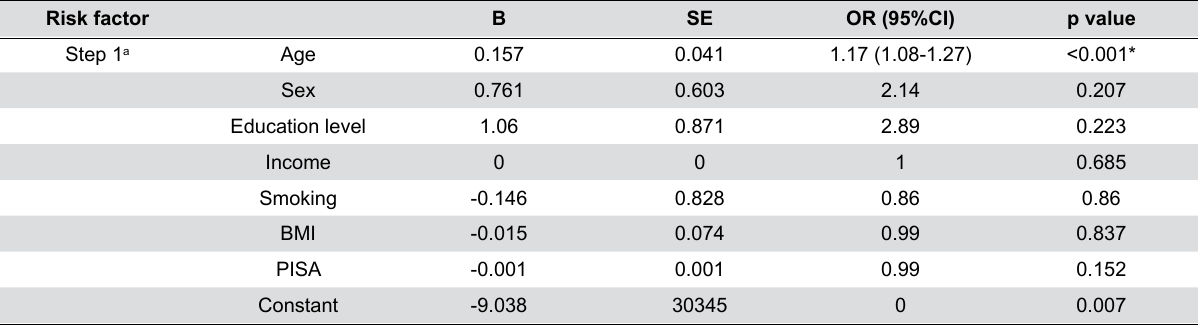
Table 5- Odds ratios (OR) and confidence intervals (CI) of multivariate logistic regression model [Factors associated with having coronary artery disease